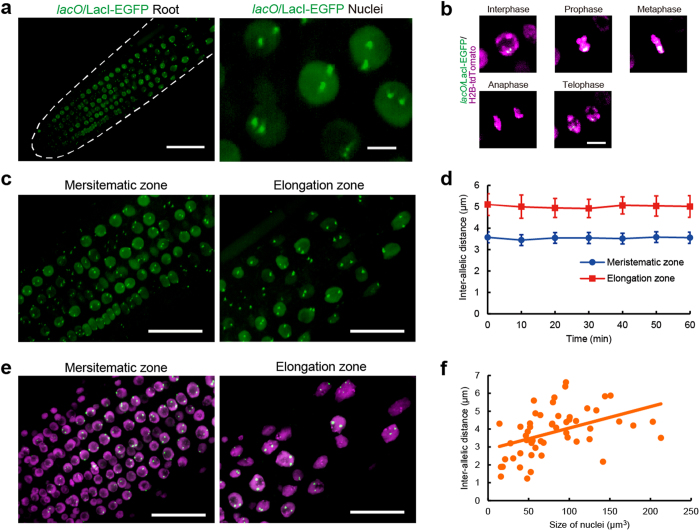
Visualisation of homologous loci with lacO/LacI-EGFP in Arabidopsis thaliana roots.a, Root (left, scale bar = 50 μm) and nucleus (right, scale bar = 5 μm) in A. thaliana expressing lacO/LacI-EGFP. The white dotted line shows the appearance of a root. b,
lacO/LacI-EGFP signals during mitosis in A. thaliana expressing lacO/LacI-EGFP in green and H2B-tdTomato in magenta. Scale bar = 5 μm. c, Nuclei in the meristematic zone and elongation zone of A. thaliana expressing lacO/LacI-EGFP. Scale bars = 30 μm. d, Dynamics of the inter-allelic distances in the meristematic zone and elongation zone nuclei (n = 20, time interval = 10 min). e, Nuclei in the meristematic zone and elongation zone of A. thaliana expressing lacO/LacI-EGFP and H2B-tdTomato. Scale bars = 30 μm. f, Correlation between the inter-allelic distance and the size of the nucleus in A. thaliana roots. The correlation coefficient was 0.44 (n = 53, **P < 0.01).